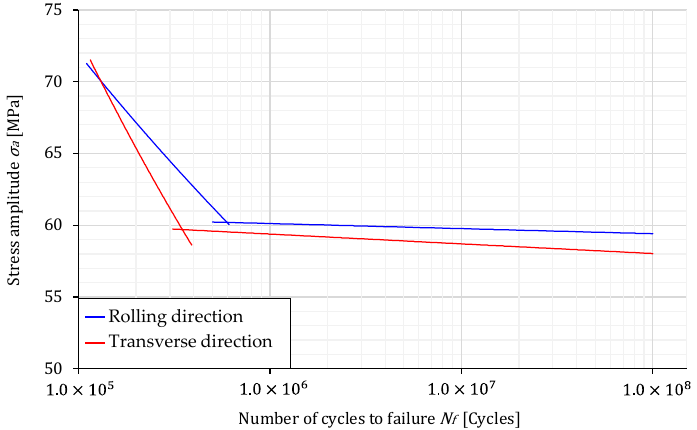
Figure 8. The comparison of S–N curve for both specimen’s directions.